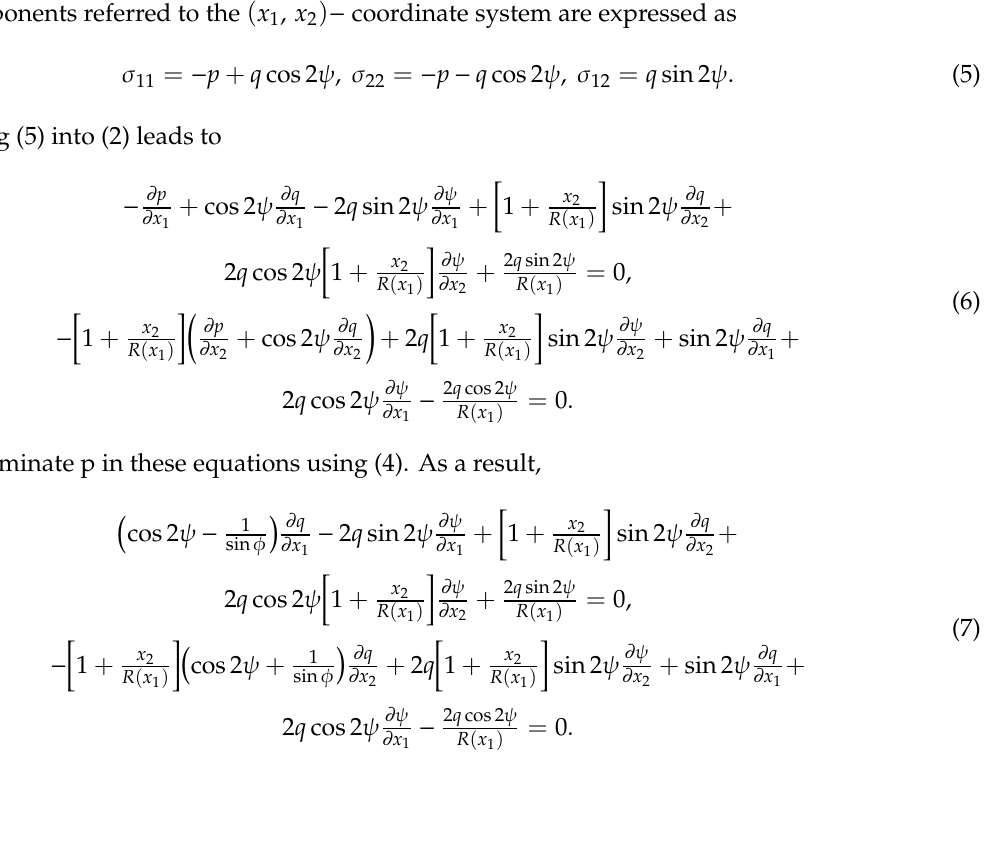
Figure 2. Orientation of the major principal stress.